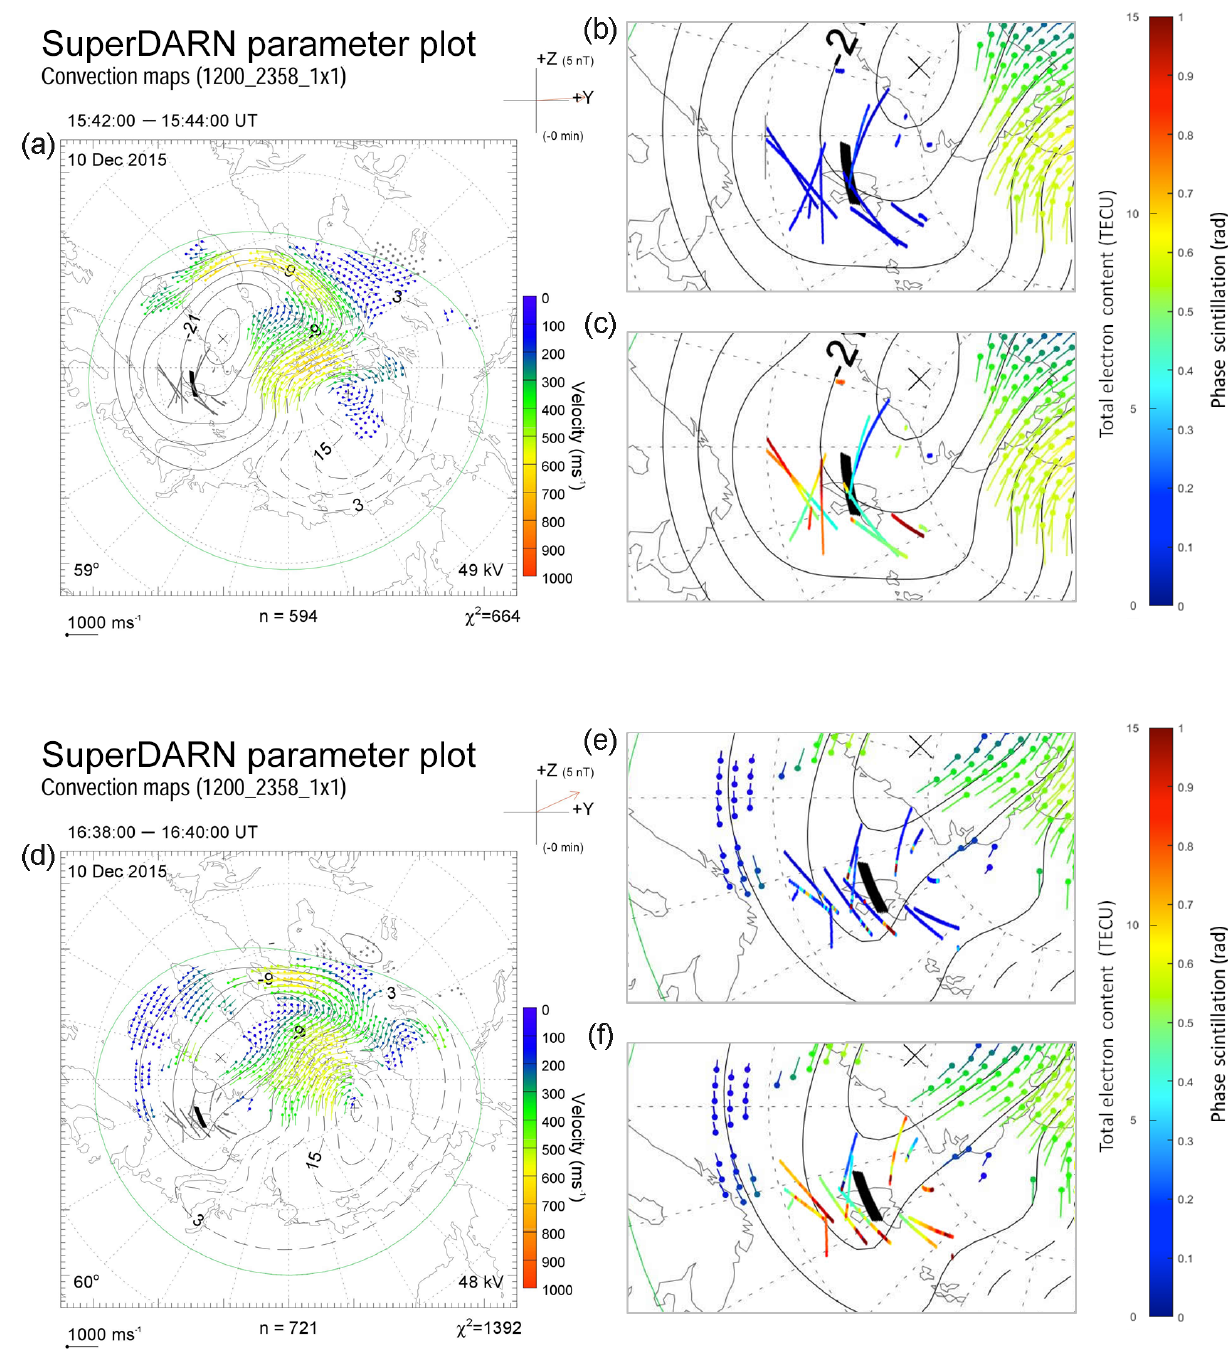
Figure 11. Electric potential patterns inferred from the SuperDARN radars for 15:42 and 16:38UT on 10 December 2015, with data from GNSS satellites overlaid in the same format as in Fig. 5. The intervals for which the satellite passes were plotted are from 15:16 to 16:14UT (15:42UT plot) and from 16:14 to 17:04UT (16:38UT